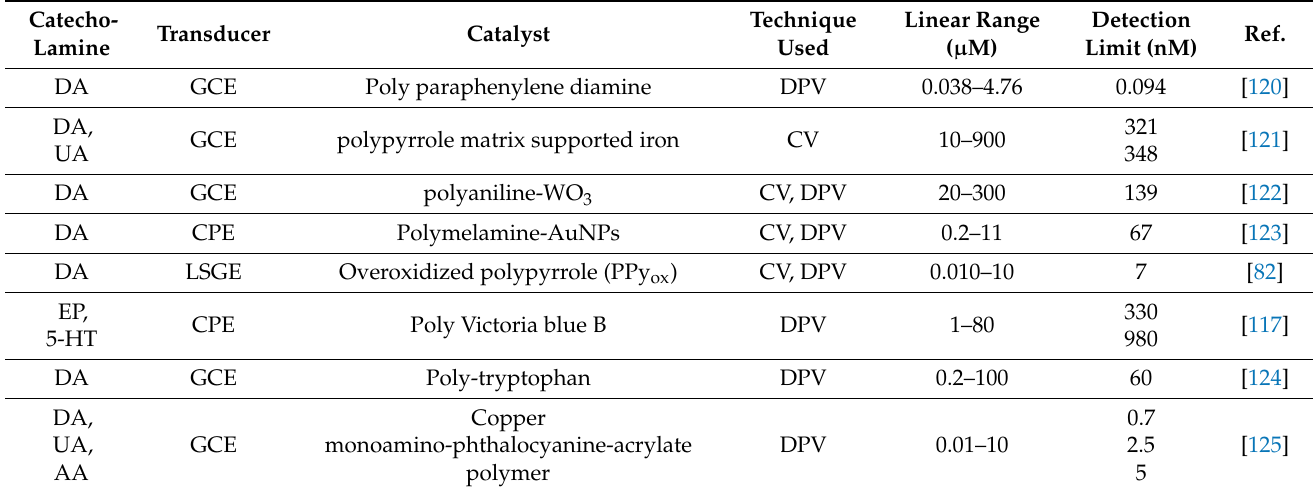
Comparison of electrochemical catecholamines sensor using electrodes modified with